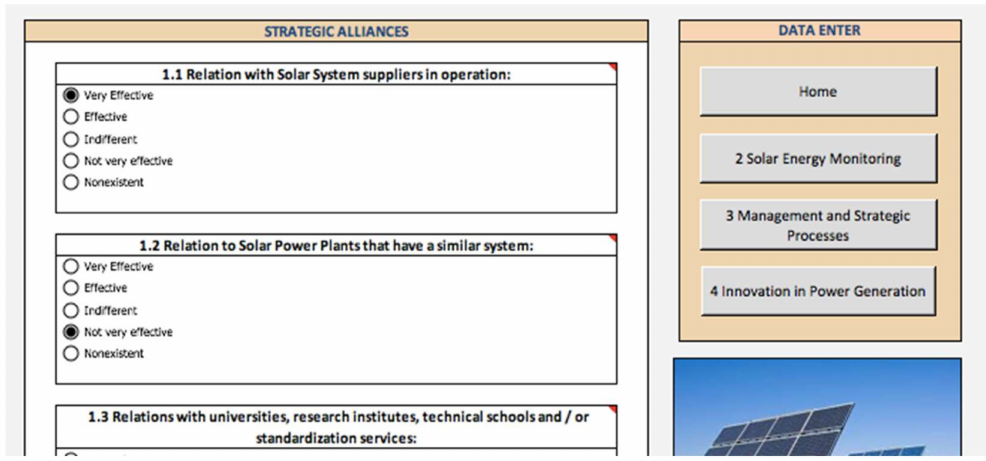
Figure 4. The cutout of the screen to illustrate the flap of the FVs in the tool: FV 1: Strategic Alliances.